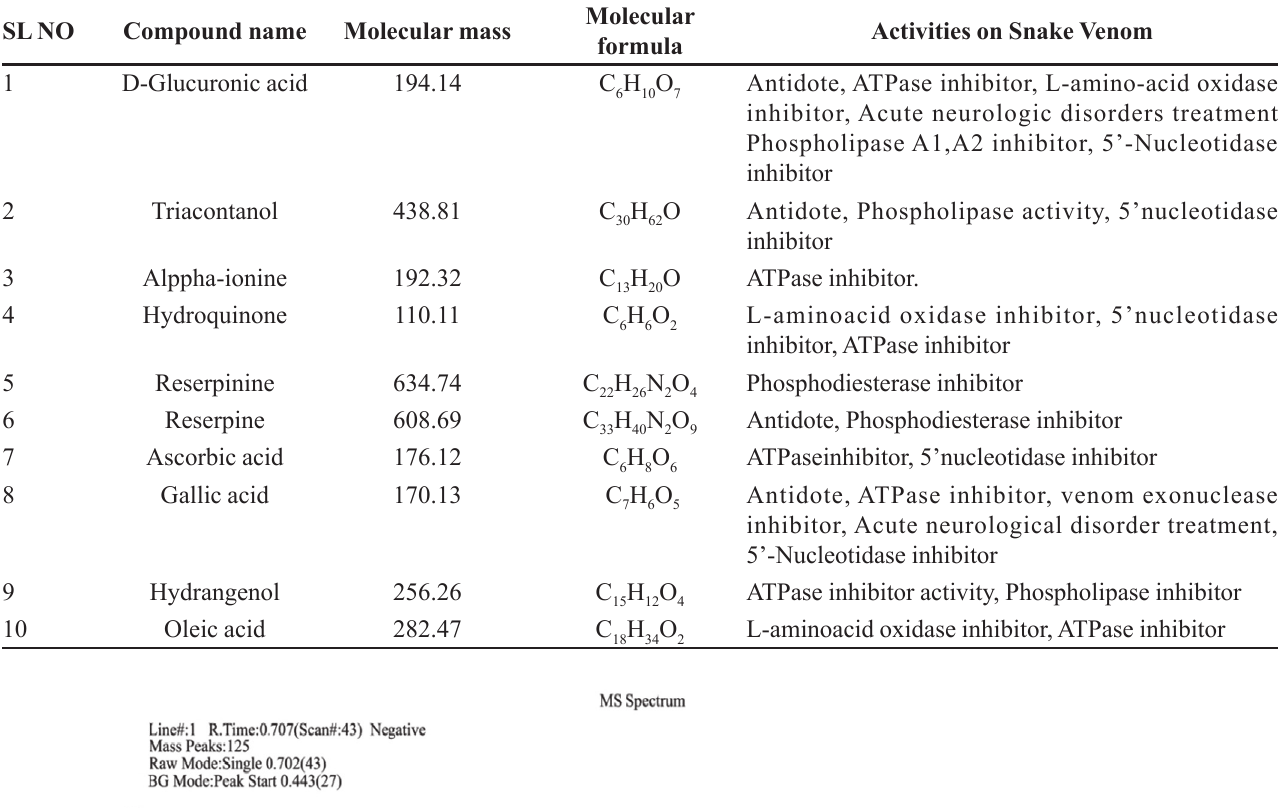
TABLE VI - Activities of the compounds identified from the extract of Rauvolfia serpentina root by LC-MS analysis (PASS)